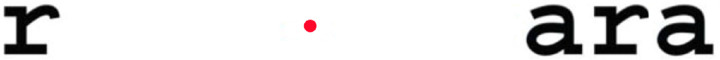
Simple illustration of crowding. Fixating on the central dot, with the page held relatively close to the eyes, the isolated “r” on the left is easy to identify, whereas the crowded “r” on the right is very difficult to identify.